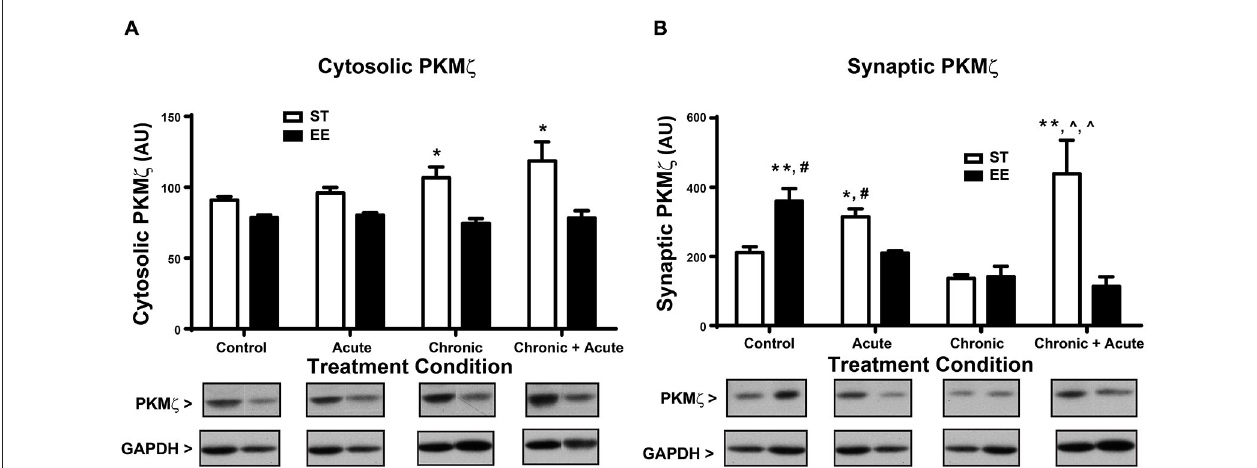
FIGURE 4 | Environmental enrichment decreases PKM ζ levels after acute stress and after chronic + acute stress. (A) ST chronic is significantly increased compared to EE chronic ( ∗ p < 0.05) and ST chronic + acute is significantly increased compared to EE chronic + acute ( ∗ p < 0.05). (B) ST chronic + acute stress significantly increased synaptic PKM ζ levels compared to EE chronic ( ∧ p < 0.01), ST chronic ( ∧ p < 0.01) and EE chronic + acute ( ∗∗ p < 0.01). EE control significantly increased synaptic PKM ζ compared to ST control ( ∗∗ p < 0.01) and compared to EE acute ( # p < 0.01). ST acute had significantly increased synaptic PKM ζ compared to EE acute ( ∗ p < 0.05) and compared to ST control ( # p <